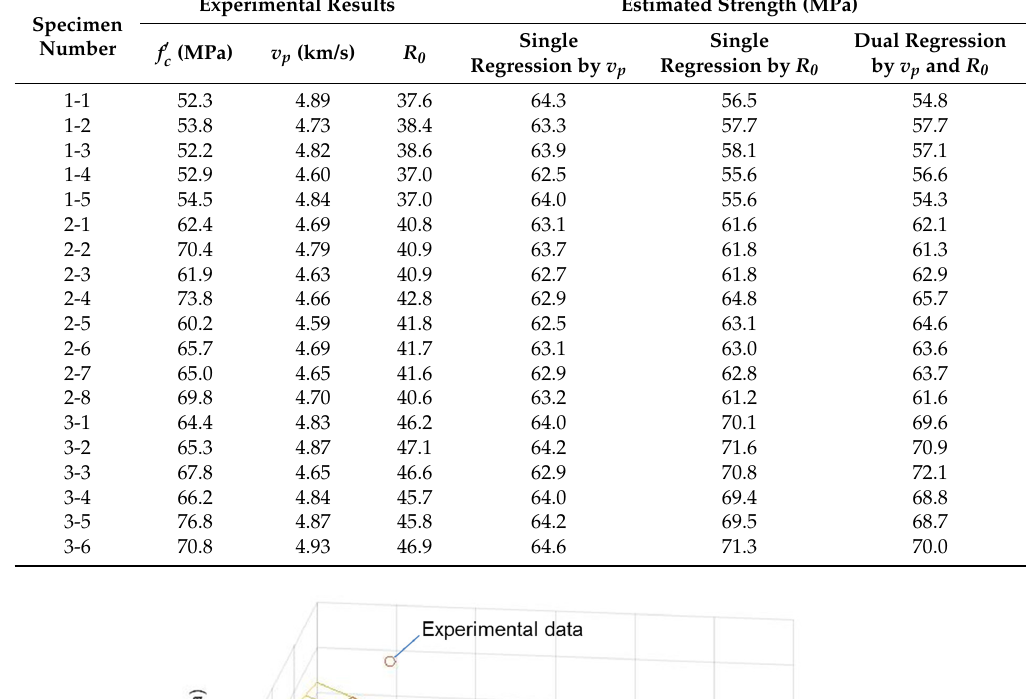
Specimen Number